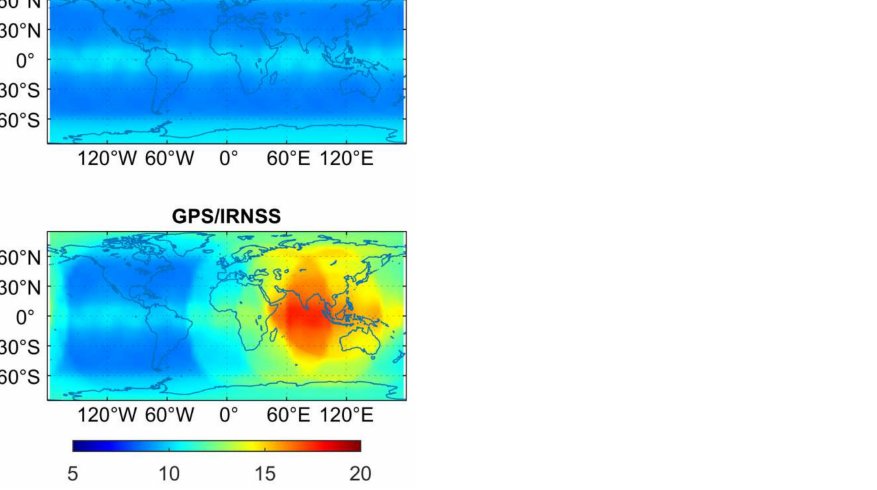
Figure 4. Average number of visible satellites for GPS-only and GPS/IRNSS cases.